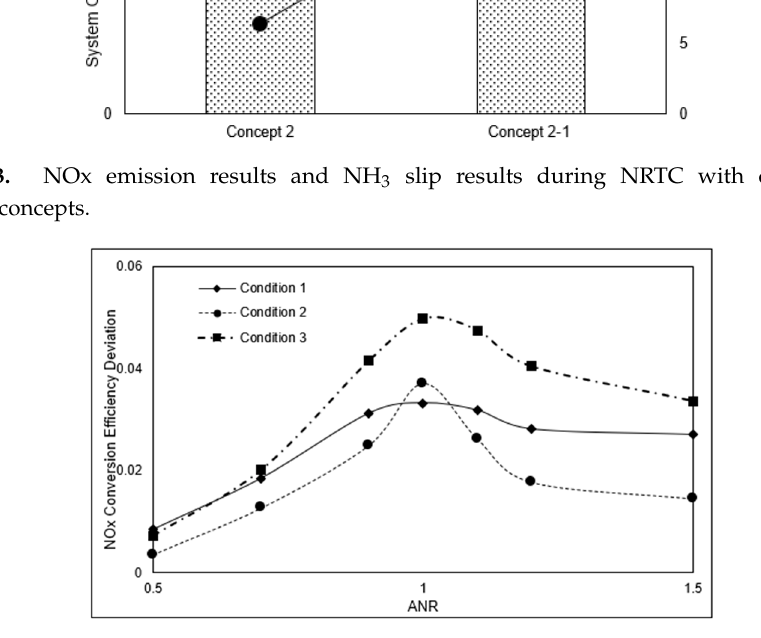
Figure 14. NOx conversion efficiency deviation with different SCR substrate concepts.